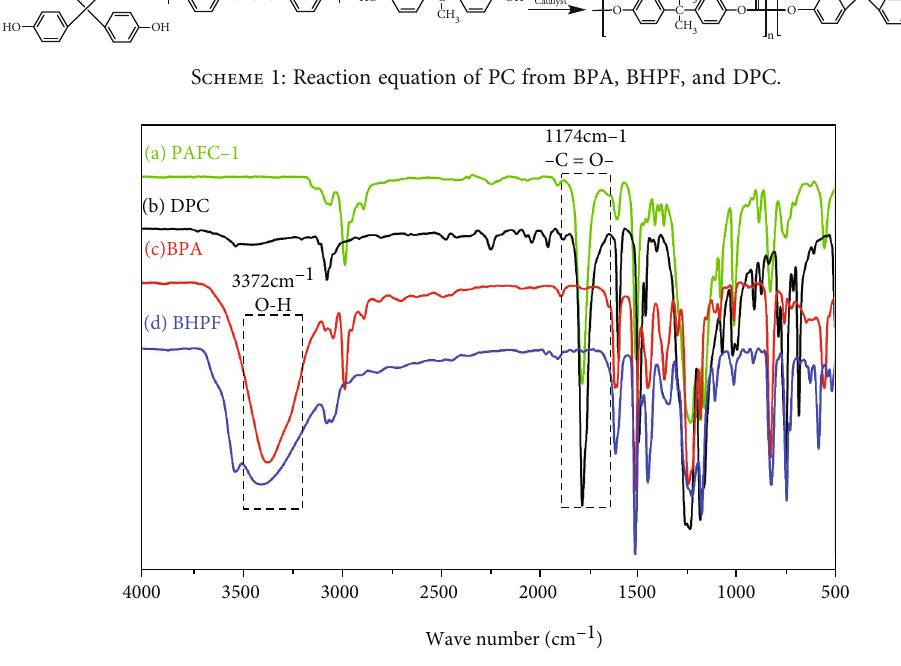
Figure 1: FTIR spectra of BPA, BHPF, DPC, and